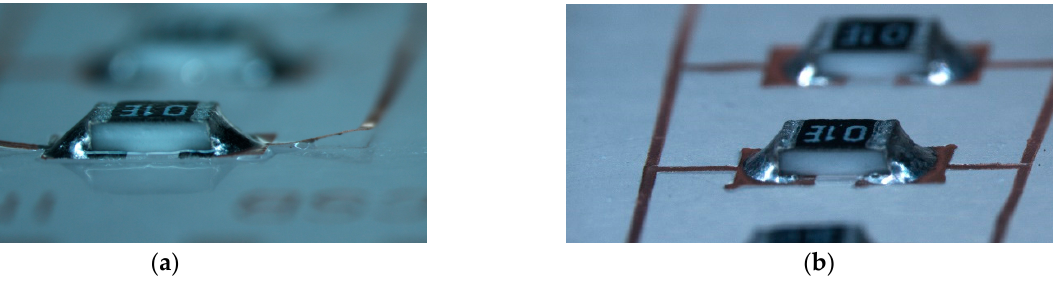
Figure 15. Soldering of pressure sensor BMP388 with SnBi solder at 180 °C (substrate: Luxaprint 3D mold). Aerosol jet printed Ag structures after electroless copper plating (15 min) ( a ). Aerosol jet printed Ag structures after electroless copper plating (15 min) and electroless plating with Ni/Au surface finish ( b ).